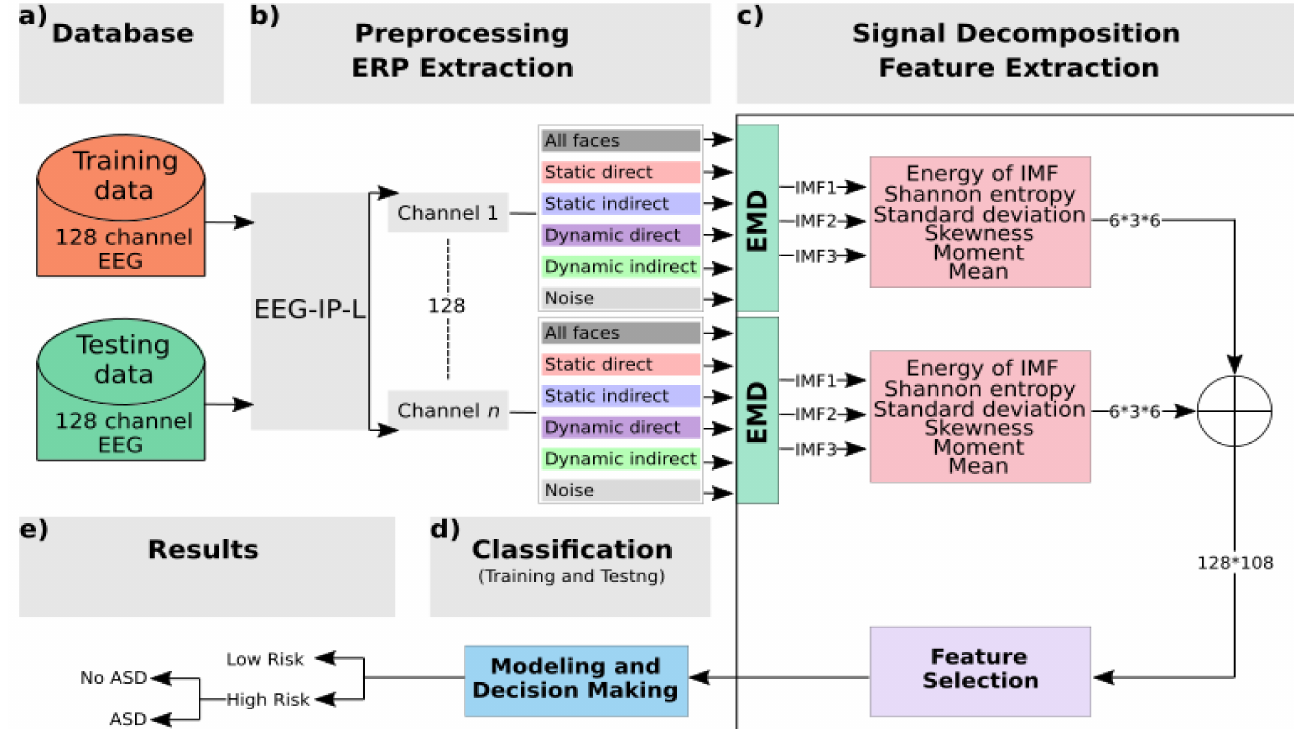
Figure 2. Block diagram of the system: ( a ) The BASIS database is split into training and testing using a nested cross- validation technique. ( b ) Preprocessing and ERP extraction: Raw EEG data were preprocessed using the EEG Integrated Platform (EEG-IP-L) pipeline [24]: all kinds of noises and artifacts are suppressed; then clean data are segmented to get fixed-length epochs. ( c ) Signal decomposition and feature extractions: empirical mode decomposition (EMD) is applied to decompose signals into intrinsic mode functions (IMFs); then features are extracted per channel and per IMF. A selection step is used to reduce the number of features. ( d ) Classification block: using nested cross validation, features selected are used as input to two classifiers, support vector machine (SVM) and k -nearest neighbors ( k -NN), at the training and testing stages. ( e ) Class labels of data are predefined to distinguish familial risk, then diagnostic outcome within the high-risk